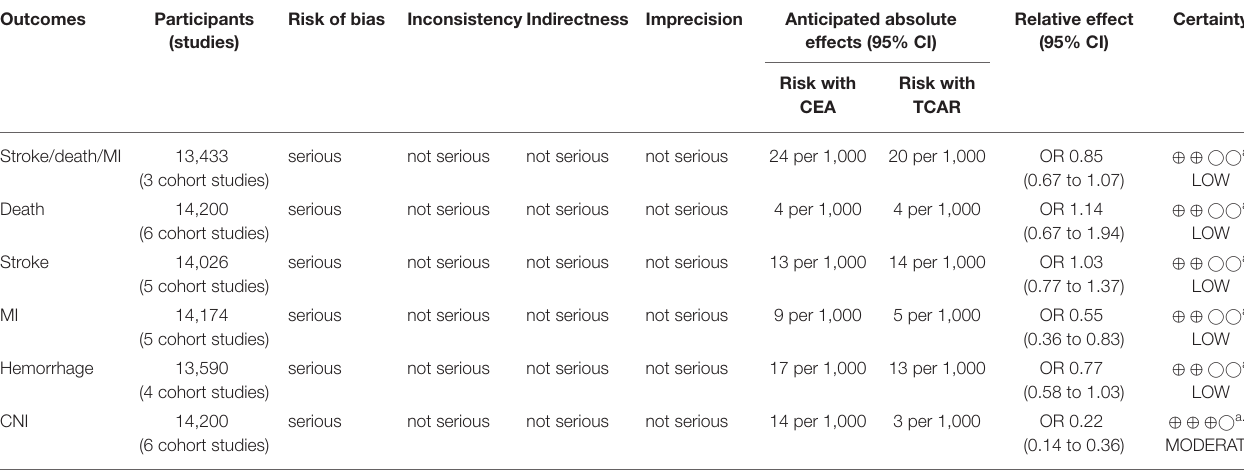
TABLE 5 | Summary of findings and bias analysis for included studies on each prognostic indicator.